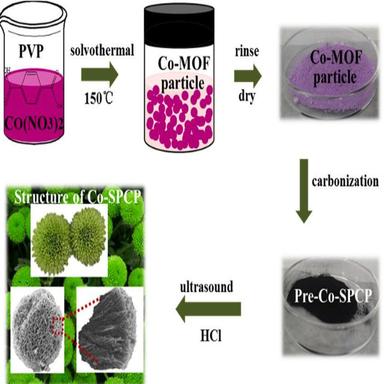
SEM images of Co-SCPC before carbonization (a-b) and Co-SCPC (c-f) with different magnification.